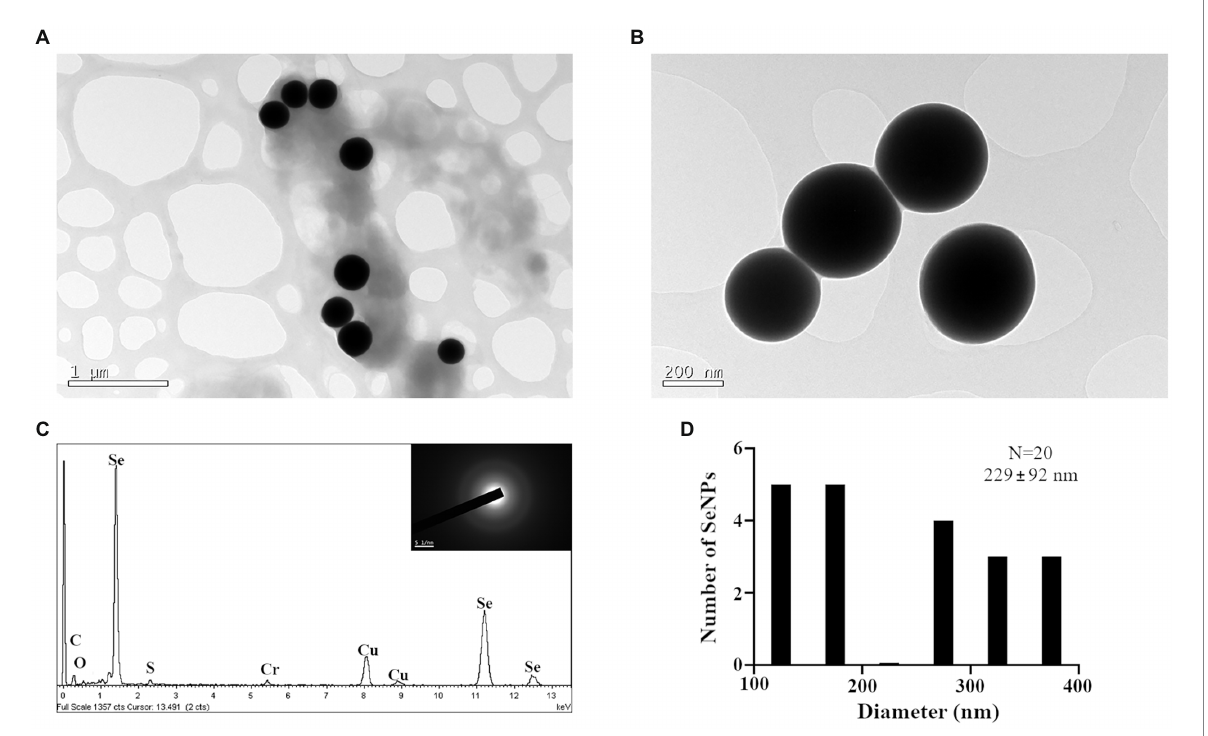
FIGURE 5 Analysis of the SeNPs produced by Arthrobacter sp. Helios. (A,B) TEM images of SeNPs produced by Arthrobacter sp. Helios. (C) EDX analysis of one SeNP composition. In the inset is shown SAED pattern of SeNPs. (D) SeNPs size distribution was calculated using the Image J software. Cells were grown for 24 h at 30 ° C in LB supplemented with 1 mM sodium